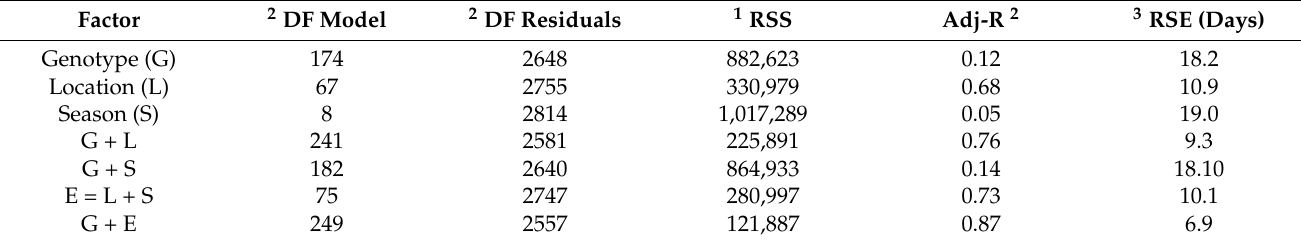
Figure 3. Geographical variation of soybean time to maturity (TTM) in the Soybean Innovation Lab Pan-African Variety Trials (SIL–PAT) network. Table 2. Sources of variation in the target variable soybean time to maturity (TTM). Additive components from G and E are displayed to visualize their relative contribution to TTM